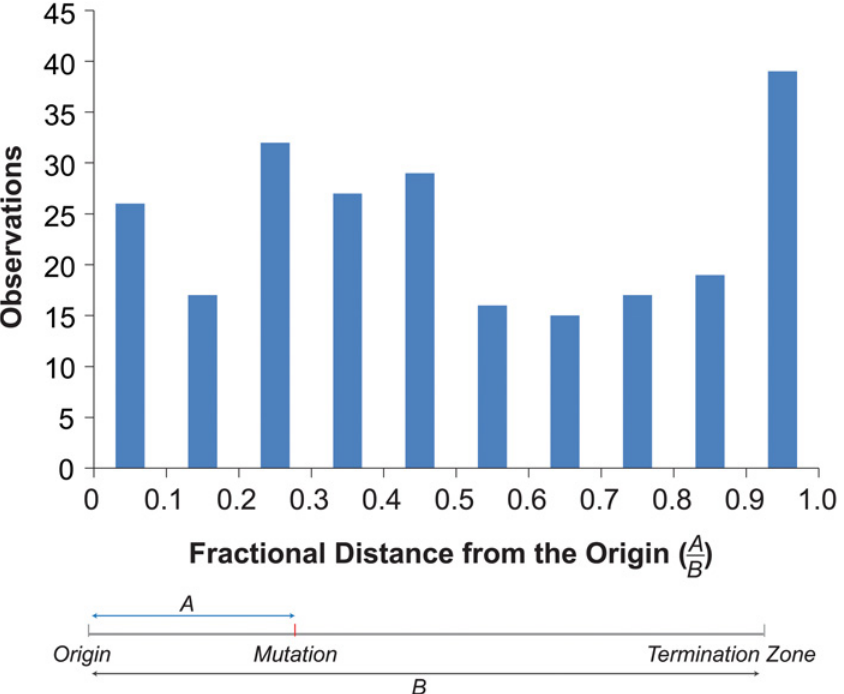
Fig 4. Distribution of mutations within replicons. Top . Histogram of the fractional distances of mutations to the nearest origin using the replicons defined by Raghuraman et al. [39] (see S3 Dataset). Bottom . Schematic shows how fractional distances are